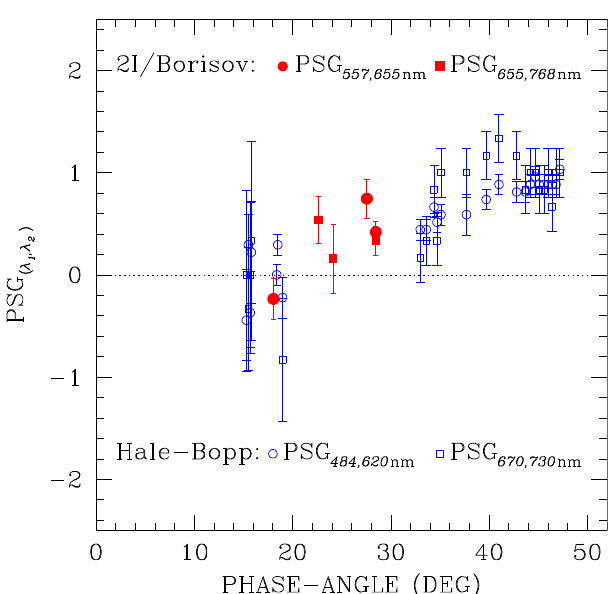
Fig. 2 Polarimetric spectral gradients (PSG) of comets 2I/Borisov and Hale-Bopp. For 2I/Borisov we used λ 1 = 557 nm, λ 2 = 655 nm (red solid circles) and λ 1 = 655 nm, λ 2 = 768nm (red solid squares); for comet Hale-Bopp 38 we used λ 1 = 484.5 nm, λ 2 = 620 nm (blue empty circles) and λ = 670 nm, λ = 730 nm (blue empty squares). Error bars represent 1 σ 1 2 uncertainties, and are calculated from simple propagation of the polarimetric uncertainties that are estimated as explained in Methods subsection Polarimetry. We note that at phase angles values ≤ 21 ∘ the polarisation is directed along the scattering plane, at phase angle ≥ 21 ∘ it is directed along the perpendicular to the scattering plane.